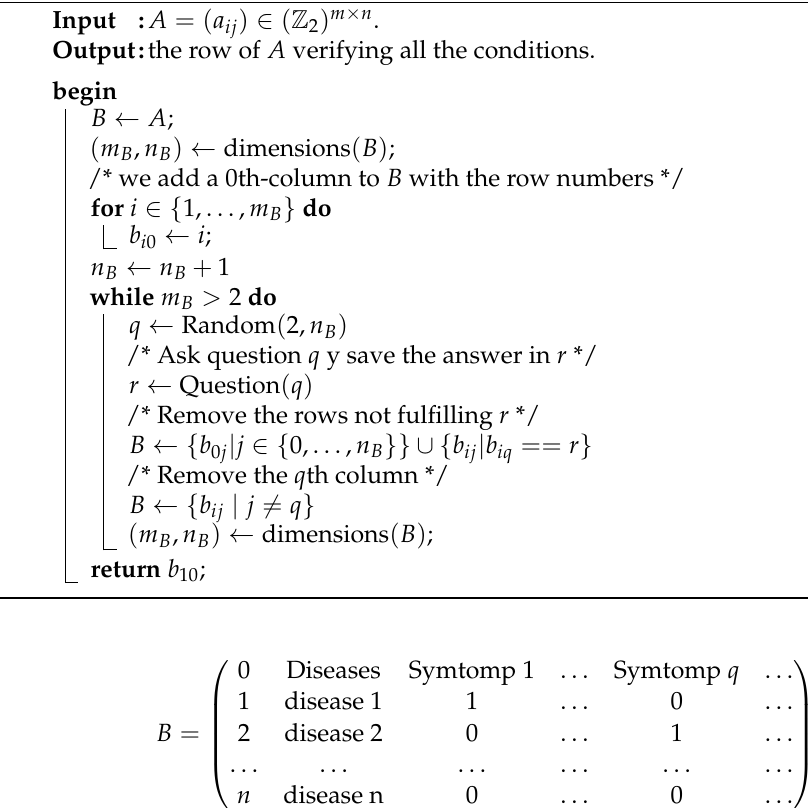
Algorithm 1: Computation of I S